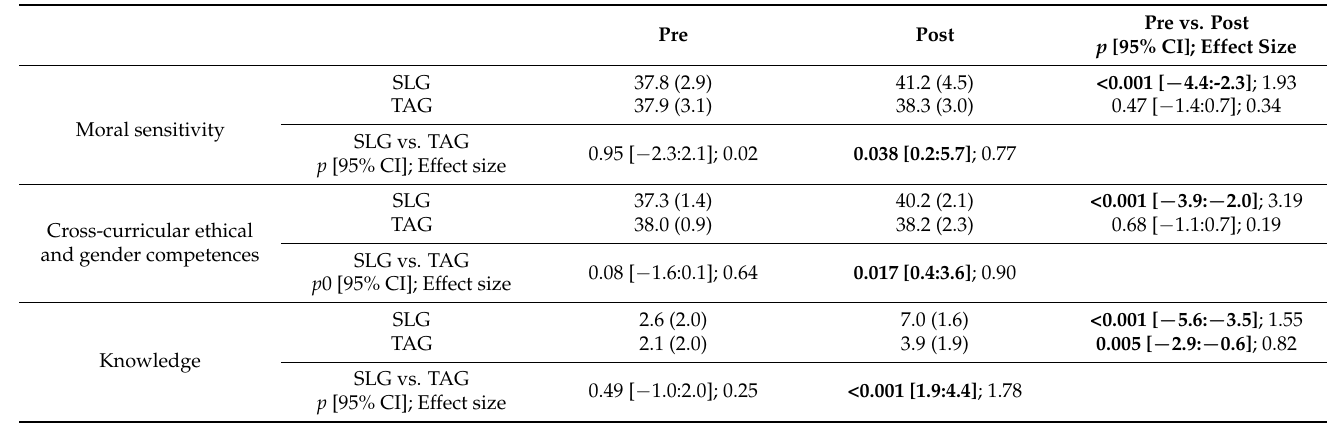
Table 2. Effect of the intervention on moral sensitivity, cross-curricular ethical and gender compe- tences, and knowledge, for the Service-Learning Group and the Traditional Approach